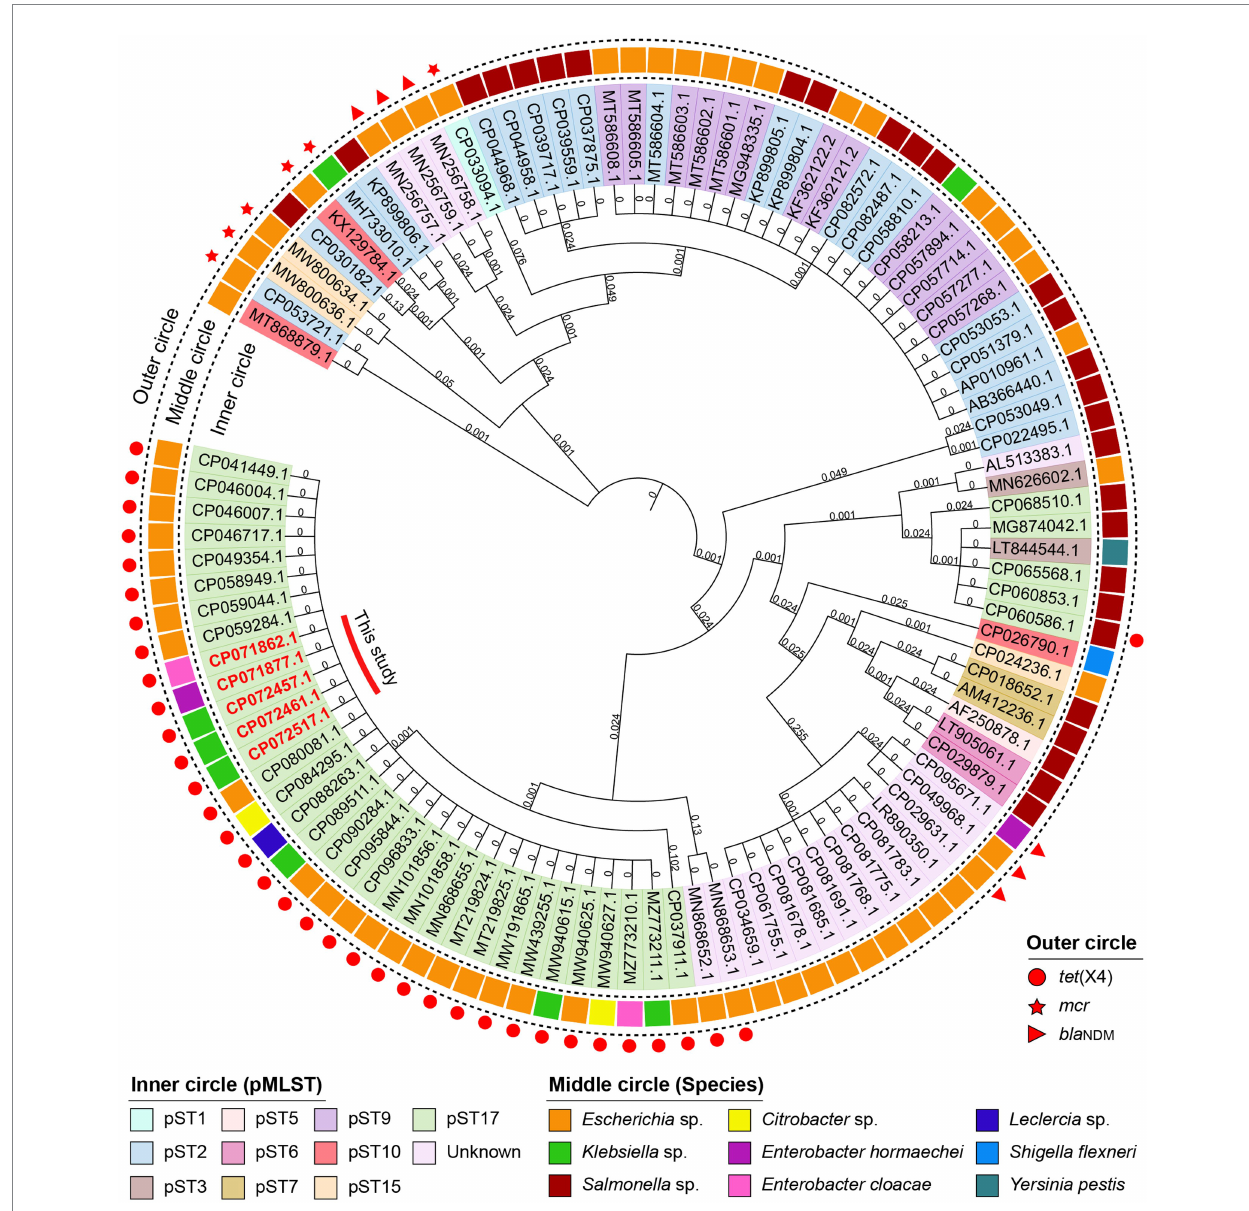
FIGURE 2 Phylogenetic tree of 100 IncHI1 plasmids with complete sequence from GenBank database. The accession numbers in red are discovered in this study. The innermost to outermost circles indicated the pMLST of plasmids, the species of isolates and the important ARGs on the